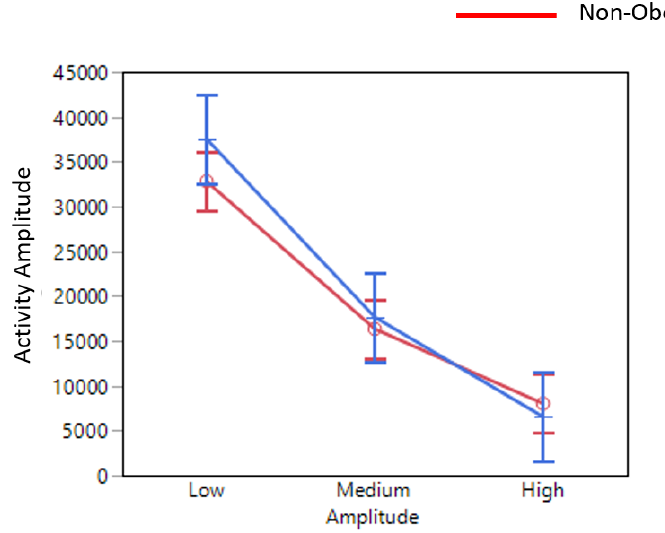
Figure 13. Activity amplitude (AA) of low, medium, and high amplitudes in obese and non-obese participants.